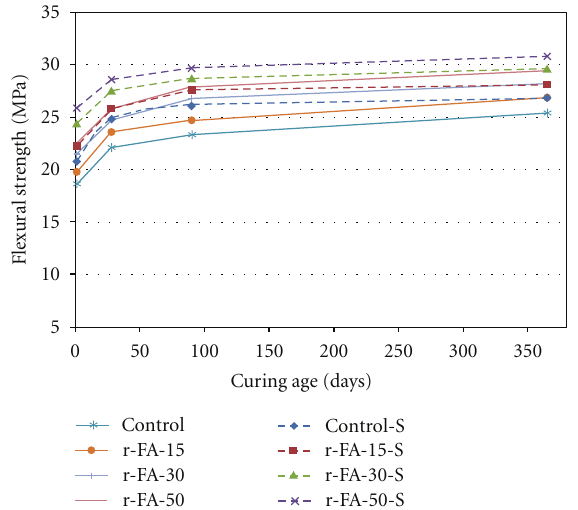
Figure 8: E ff ect of GP on fracture energy of UHPFRC with and without steam